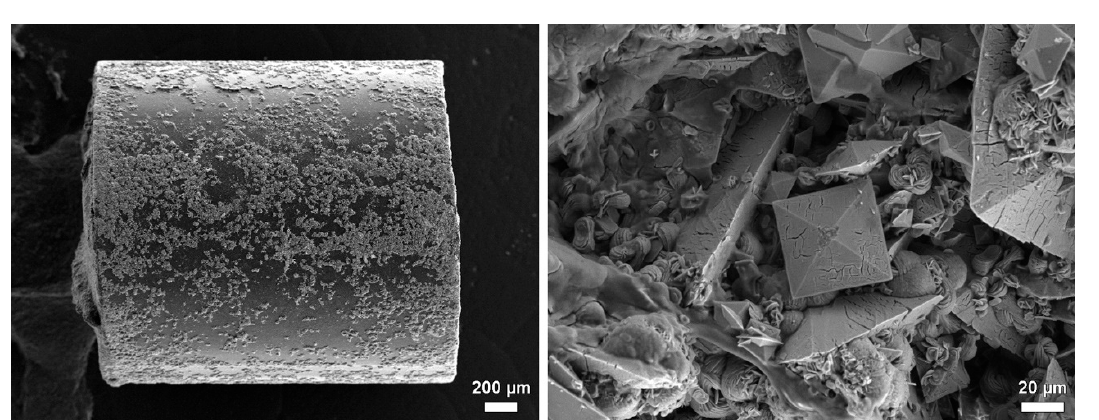
Figure 12. SEM of an encrusted sample surface, Elastollan + barium sulphate + a-C:H/Cu-mulitilayer coating, indwelling time 21 days. FE-SEM Merlin VP compact (Zeiss, Germany).